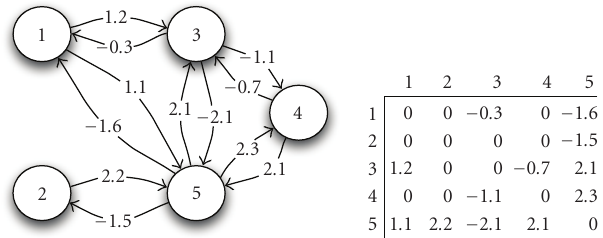
Figure 3: Directed graph representing (hypothetical) strengths of species interactions and the corresponding matrix of interaction strengths. Positive (negative) values indicate increase (decrease) in receiving species’ fitness. Units of interaction are unspecified in this example, but may be observed changes in biomass. For example, species 1 may produce a metabolite beneficial to species 3( a 31 = 1 . 2), while 3 occasionally harms 1( a 13 = − 0 . 3) while consuming the metabolite. Species 3 and 4 are competitors, 5 and 4 are mutualists, and other pairs resemble